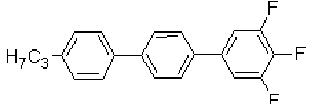
Figure 1. Chemical structure of trifluoro ‐ terphenyl compound.